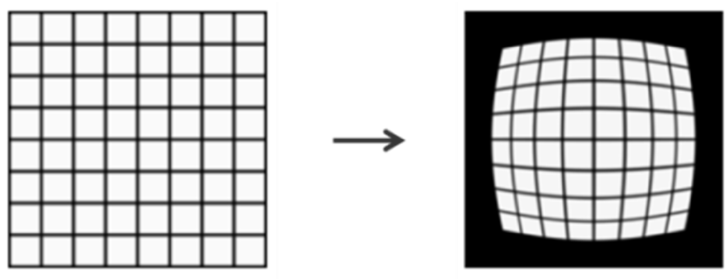
Figure 2. Schematic diagram of image distortion